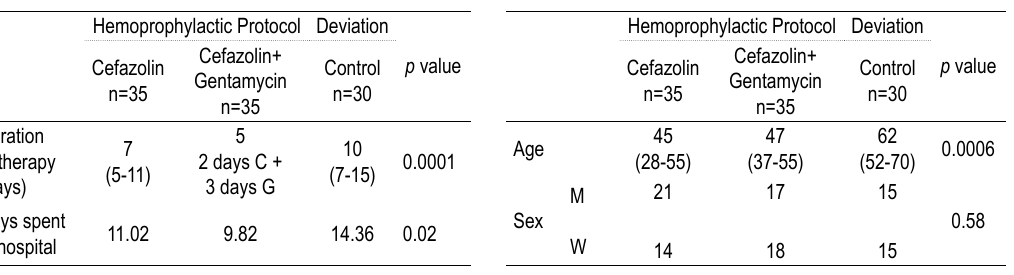
Table 3. Duration of hemoprophylactic therapy Table 4. Distribution of respondents by age and